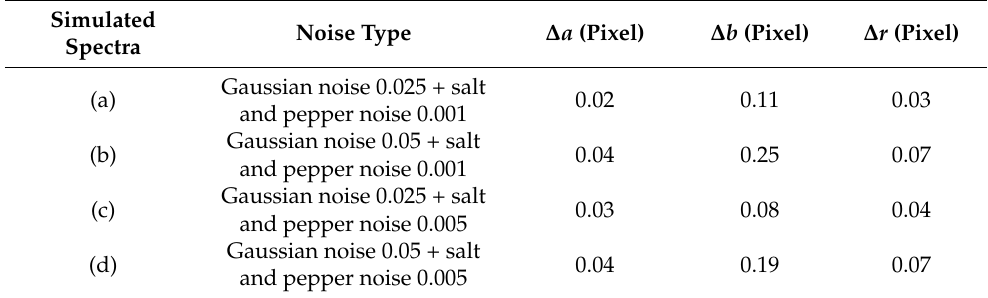
Figure 9. Simulated spectra with different noises. ( a ) Gaussian noise 0.025 + salt and pepper noise 0.001; ( b ) Gaussian noise 0.05 + salt and pepper noise 0.001; ( c ) Gaussian noise 0.025 + salt and pepper noise 0.005; and ( d ) Gaussian noise 0.05 + salt and pepper noise 0.005. Table 2. Processing results of simulated spectra after adding different noises. Simulated